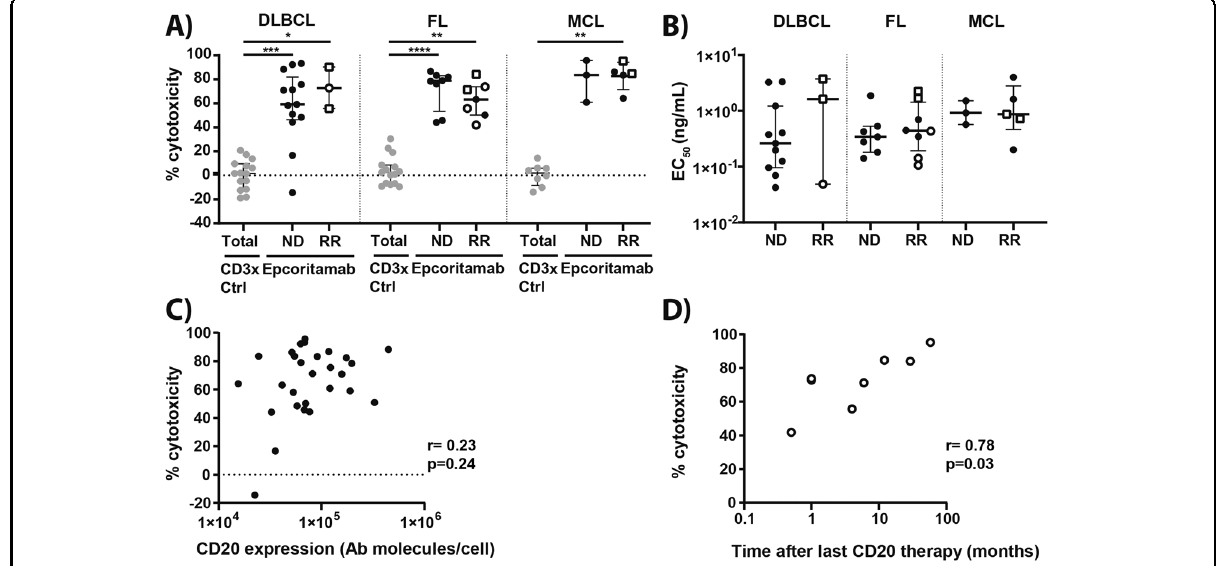
Fig. 1 Epcoritamab mediates comparable levels of cytotoxicity in various B-NHL subtypes and in ND and RR samples, including samples from patients who received prior CD20-antibody containing treatment. A Percentages cytotoxicity mediated by epcoritamab and CD3xCtrl (30 ng/mL) and B EC 50 values (ng/mL), shown for samples with clear dose-response curves, for cytotoxicity in the presence of allogeneic PBMCs (E:T ratio 10:1) in ND and RR DLBCL ( n = 16), FL ( n = 15), and MCL ( n = 8) samples (median ± interquartile range), including patients who relapsed from or were refractory to CD20 therapy ( and , respectively). Statistical analysis was performed with Kruskal – Wallis and Dunn ’ s multiple comparisons test to compare epcoritamab with CD3xCtrl for each indication (* p < 0.05; ** p < 0.01; *** p < 0.001; **** p < 0.0001) and epcoritamab-dependent cytotoxicity between subtypes (ns ( C ) CD20 expression (antibody molecules per cell) on tumor cells in samples from B-NHL patients unexposed to prior CD20 therapy correlated to epcoritamab-dependent cytotoxicity (30 ng/mL) (Spearman ’ s; ns). D Time between last CD20-therapy and moment of lymph node biopsy (months) of patients previously treated with CD20-antibody containing treatment ( n = 8) correlated to cytotoxicity mediated by epcoritamab (30 ng/mL) (Spearman ’ s; r = 0.78, * p =